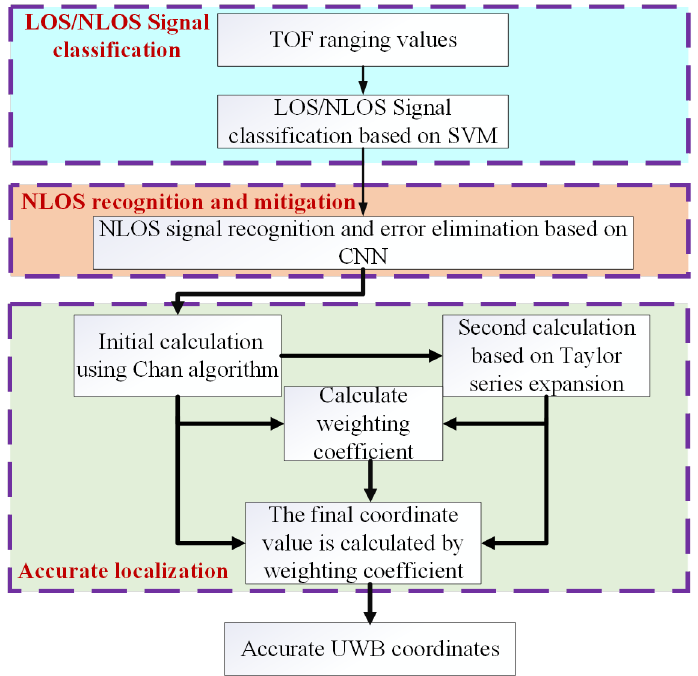
Figure 6. General flow chart of C-T-CNN-SVM